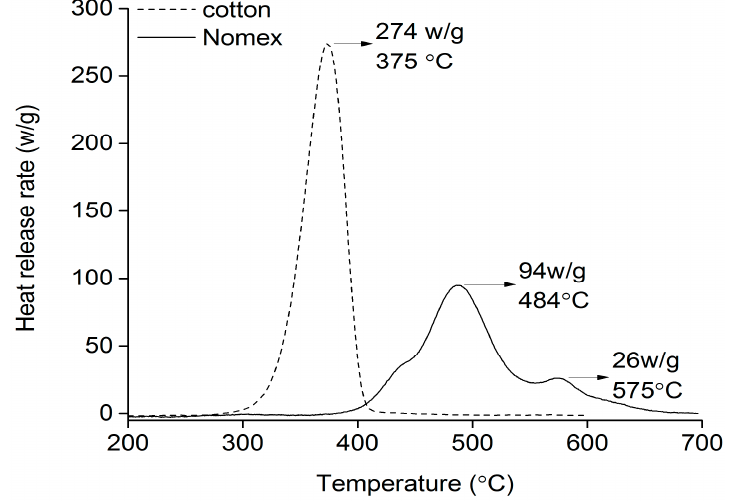
Figure 1. The heat release rate vs. temperature curves of cotton and Nomex ® fabrics.